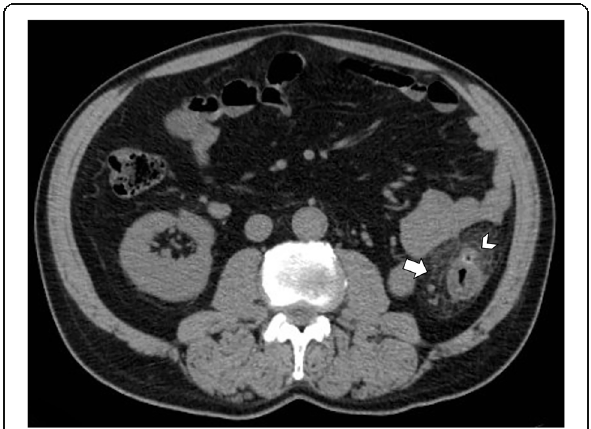
Fig. 11 Acute diverticulitis in a 55-year-old man. Axial non-contrast CT image shows segmental thickening of descending colon,